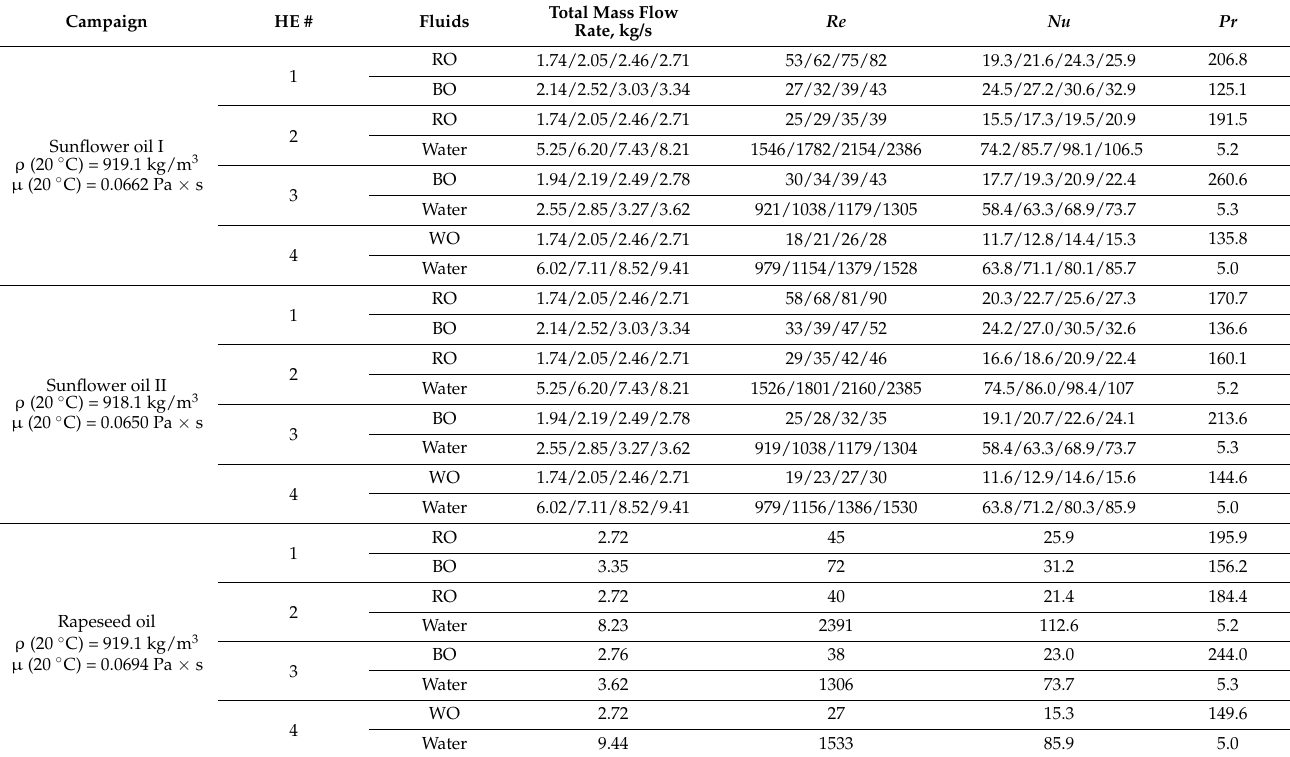
Table 5. Re, Nu and Pr criteria for chevron 30 ◦ channel related to cross sectional area transverse to the main flow